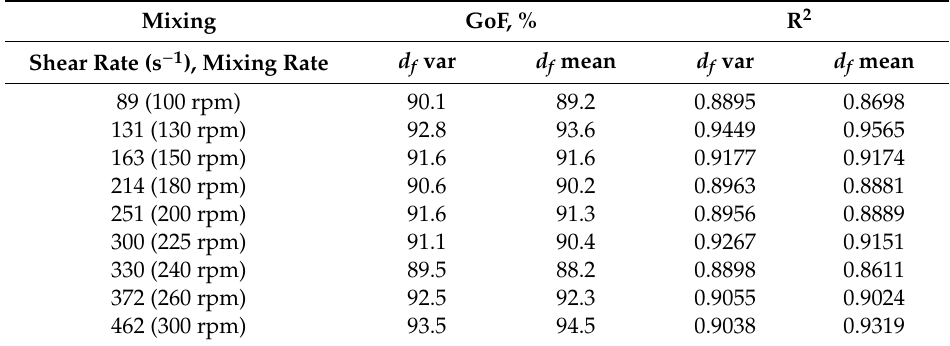
Figure 3. Flocculation kinetics of synthetic tailing particles in seawater at pH 8 as a function of shear stress (G). Open circles correspond to experimental data and solid lines to the best fit with the population balance model (PBM). ( A ): Shear rate range from 89–251 s − 1 . ( B ): Shear rate range from 300–462 s − 1 . Table 2. Quantitative results of GoF and R 2 when the PBM is used with constant fractal dimension ( 𝑑 (cid:3033) mean) or variable ( 𝑑 (cid:3033) var) fractal dimension dependent on flocculation time.